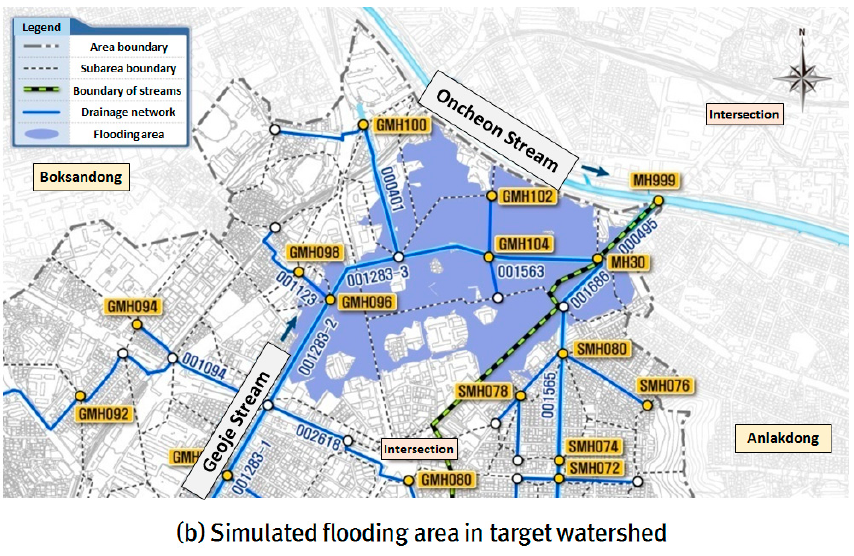
Figure 6. Validation of the drainage network matching the flooding area in the target watershed.